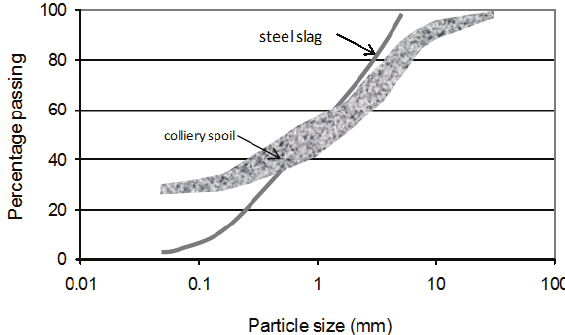
Fig. 3. Particle size distribution of colliery spoil from Car Wood and BOS